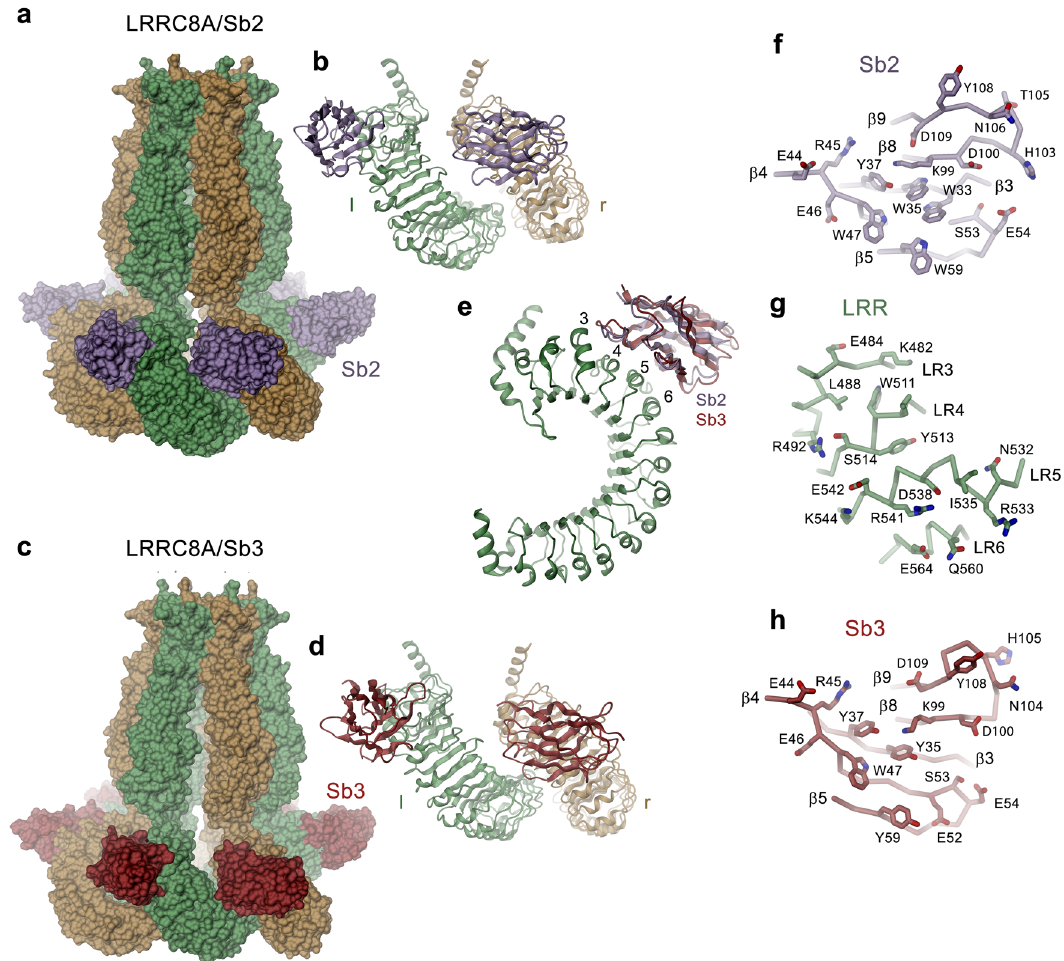
Fig. 5 Structure of LRRC8A in complex with the inhibitory sybodies Sb2 and Sb3. a Surface representation of the LRRC8A/Sb2 complex structure. b Structure of the dimer of interacting domains at the tight interface with bound sybody Sb2. c Surface representation of the LRRC8A/Sb3 complex structure. d Structure of the dimer of interacting domains at the tight interface with bound sybody Sb3. b , d Left (l) and right (r) positions are indicated. e Ribbon representation of a single LRR domain with bound sybodies Sb2 and Sb3. Repeats contacted by both sybodies are labeled. f View on the interaction interface of a homology model of Sb2 based on the Sb3 structure, g the LRRC8A domain and, h Sb3. The protein is shown as C α trace with the sidechains of interacting residues displayed as